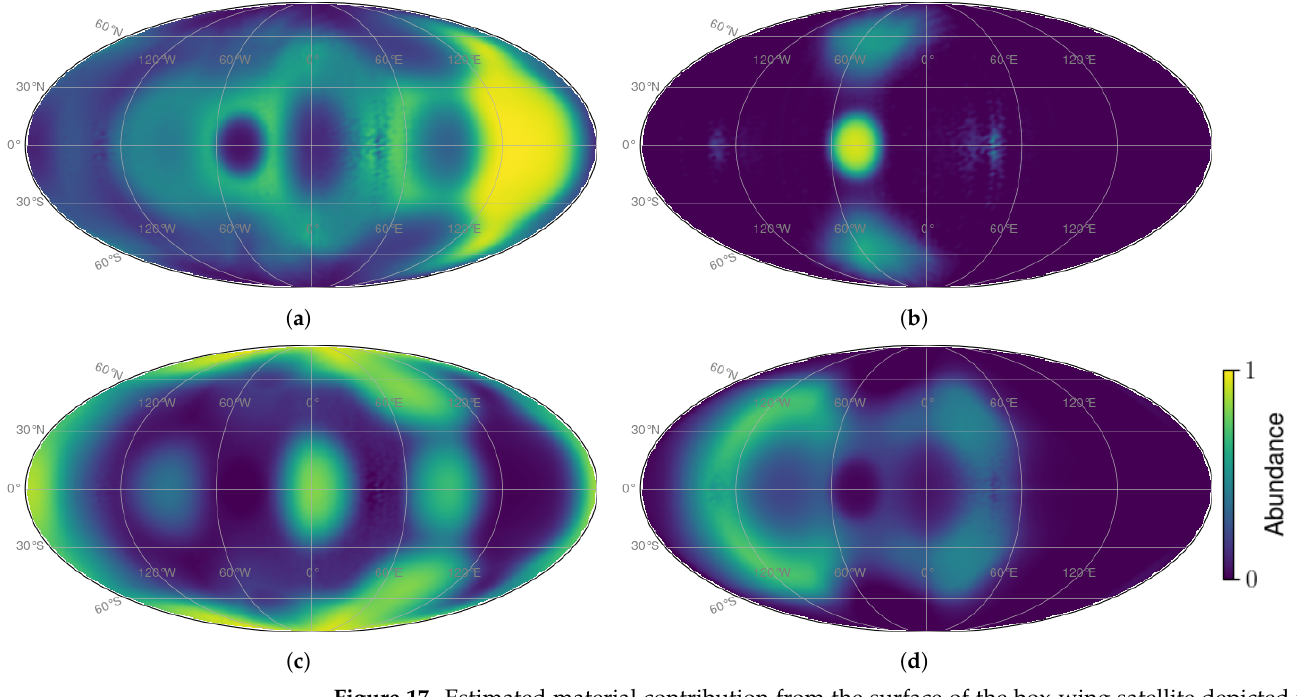
Figure 17. Estimated material contribution from the surface of the box-wing satellite depicted in Figure 4 obtained from backscattering simulations under solar radiation. ( a ) Aluminium. ( b ) Solar Cell. ( c ) MLI. ( d ) White paint